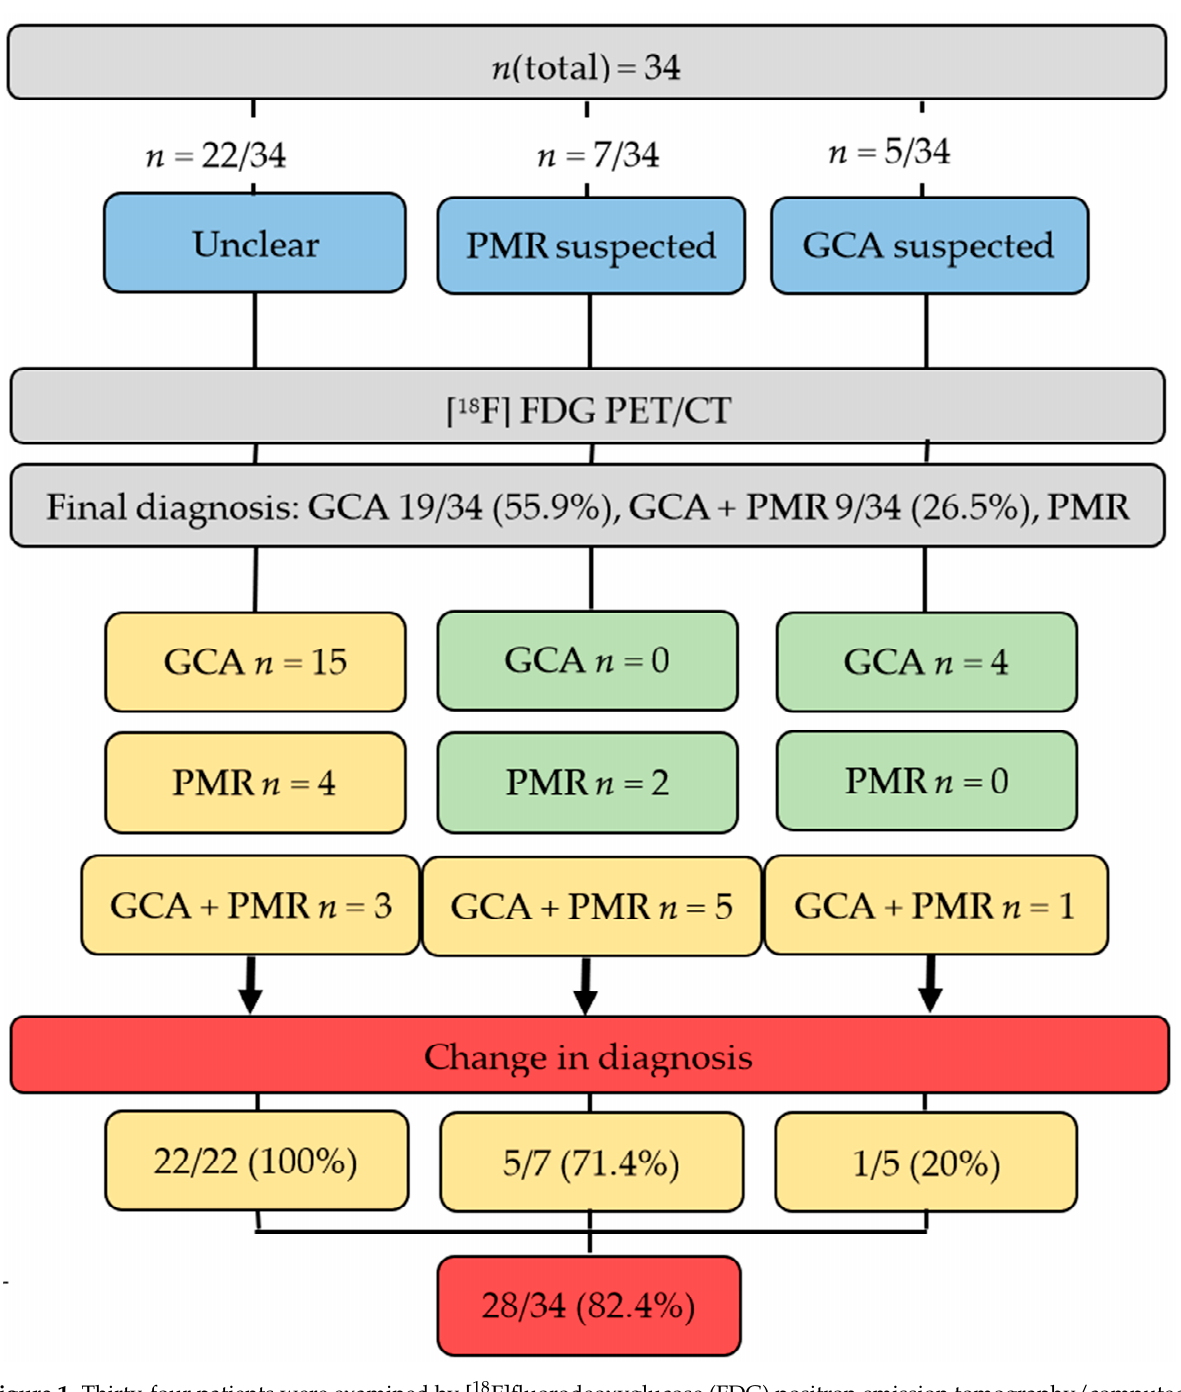
Figure 1. Thirty-four patients were examined by [ 18 F]fluorodeoxyglucose (FDG) positron emission tomography/computed tomography (PET/CT) with unclear diagnosis or suspected giant cell arteritis (GCA) or polymyalgia rheumatica (PMR). In 28/34 (82.4%), [ 18 F]FDG PET/CT was able to establish the diagnosis (red). In the remaining 6/34 (17.6%), [ 18 F]FDG PET/CT had no additional benefit (green). The greatest benefit was recorded in an unclear situation (22/22 [100%]), with the vast majority having a final diagnosis of GCA (15/22 [68.2%]), followed by PMR in 4/22 (18.2%) and GCA + PMR in the remaining 3/22 (13.6%) (yellow).